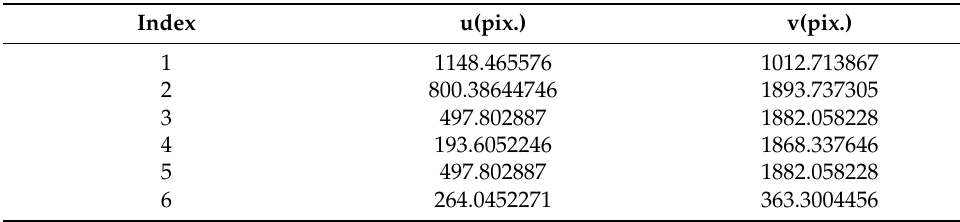
Table 1. Pixel coordinates of some corners of calibration board.